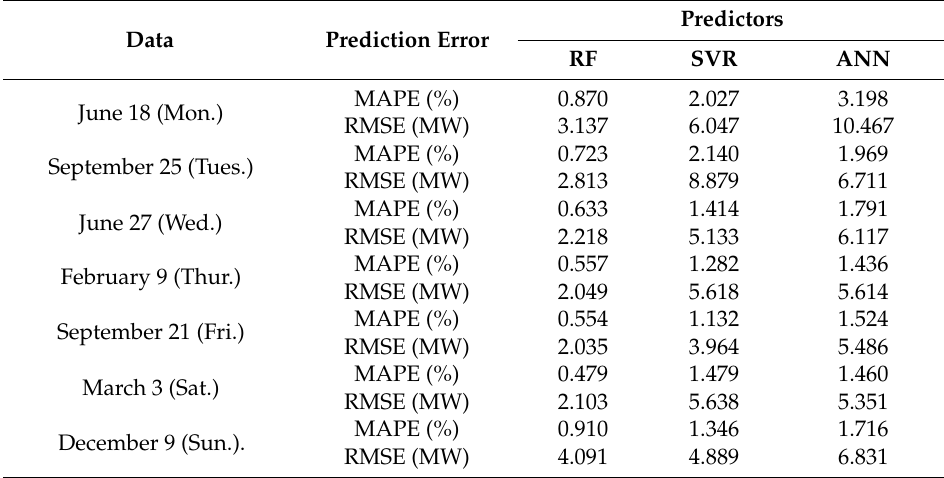
Table 12. Prediction error of different predictors of the selected seven test days when 1-h-ahead prediction is conducted.